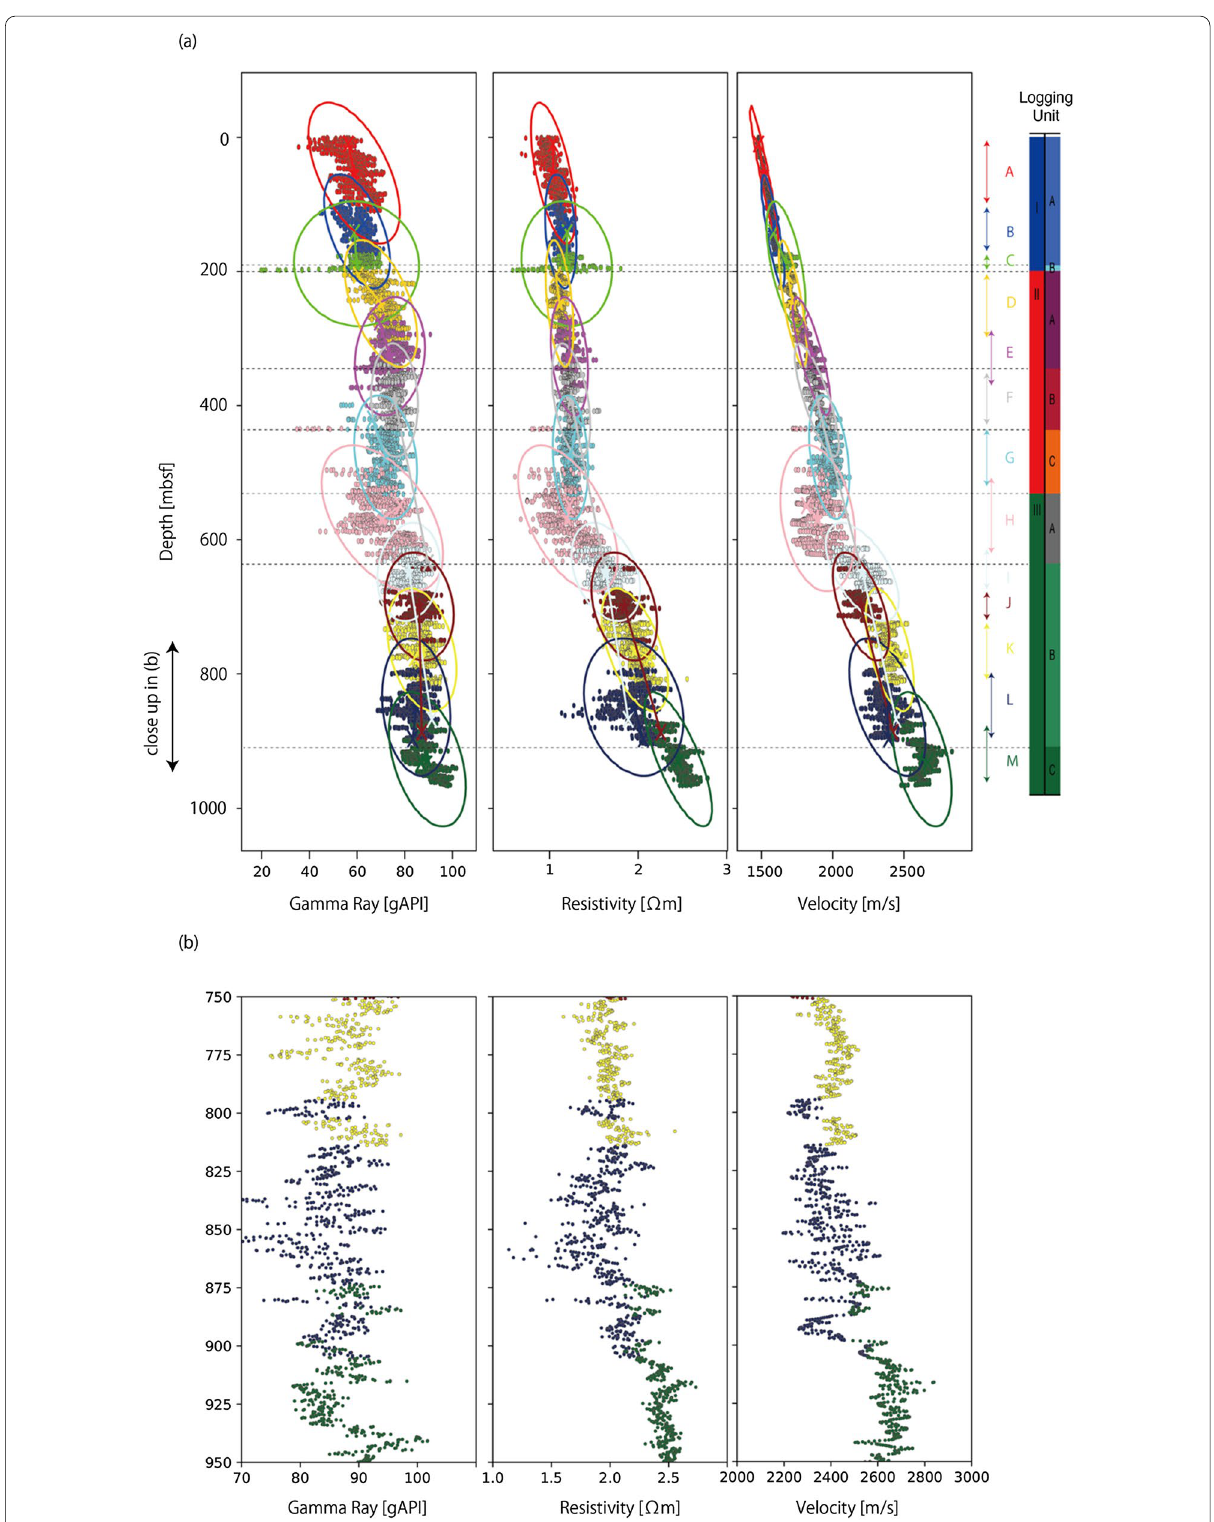
Fig. 4 Clustering results at C0001 and previously reported log units (Expedition 314 Scientists 2009b). Ellipses represent covariance of each cluster. a The entire section, and b the close‑up figure of a where noted by a black arrow on the